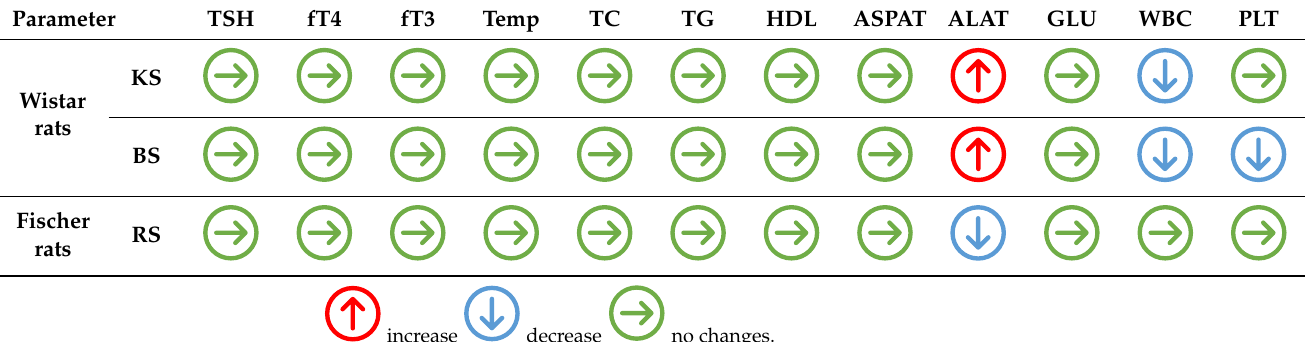
increase decrease no changes.